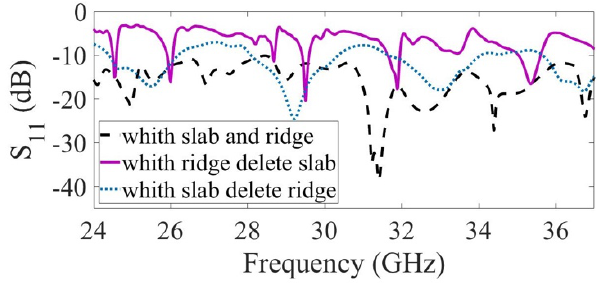
FIGURE 4. Simulated reflection coefficient of the antenna obtained through CST.